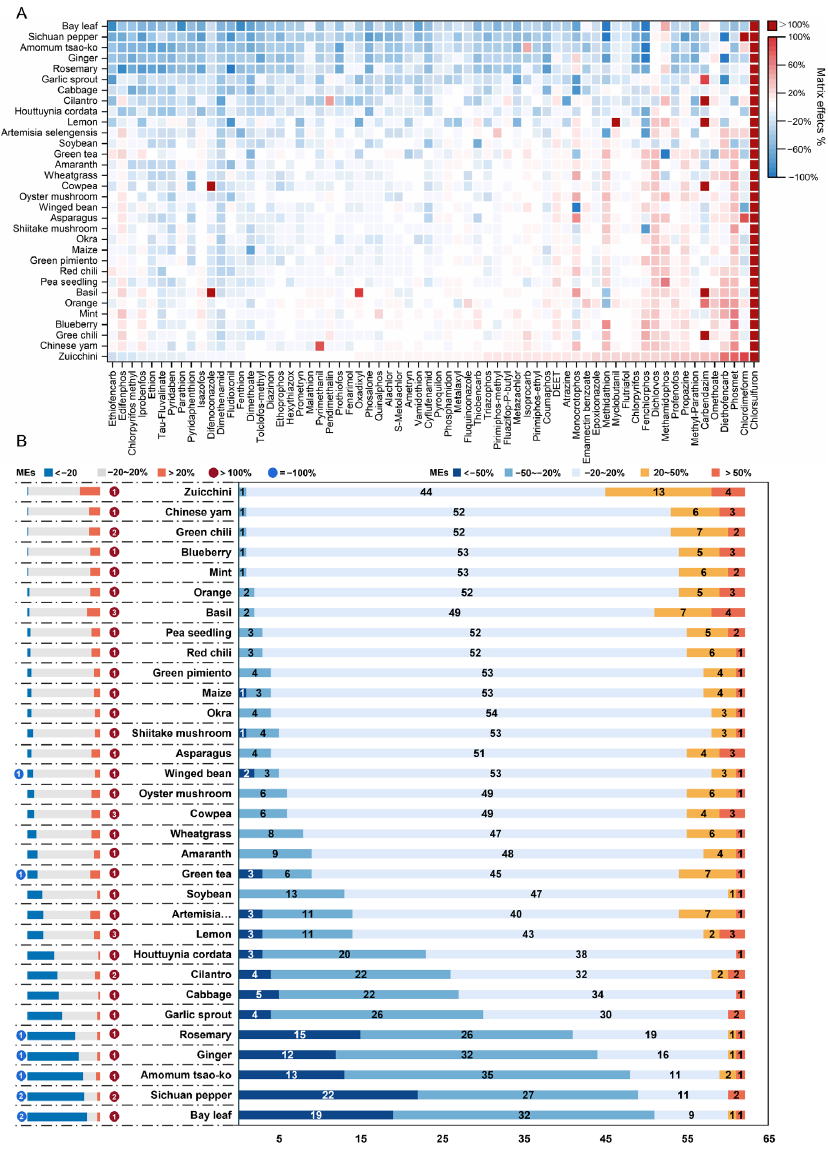
Figure 4. Distribution of matrix effects (MEs) on 62 pesticides in 32 matrices ( A ) and the comparison of MEs in different matrix species ( B ) in the TOF-MS scan under IDA mode.